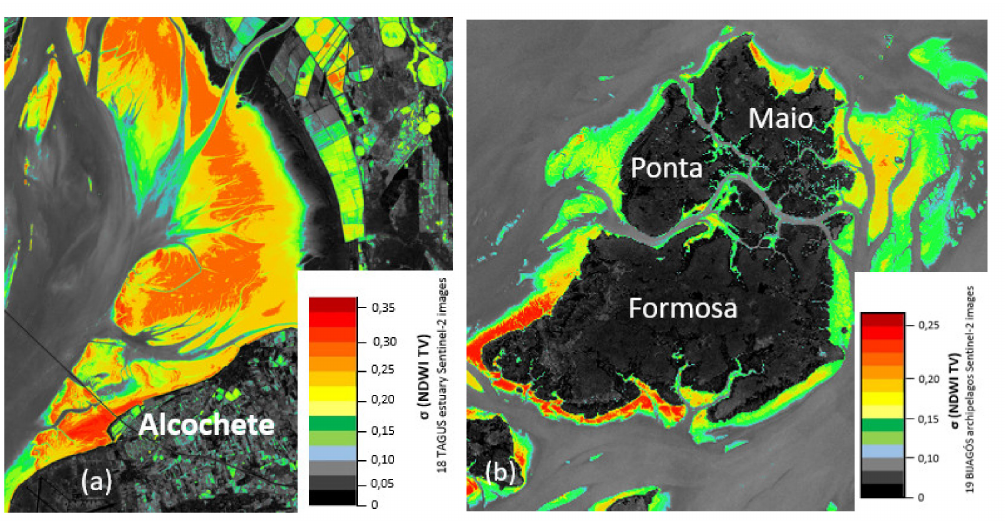
Figure 7. Normalized Di ff erence Water Index (NDWI) temporal variability: ( a ) Alcochete area in Tagus estuary and ( b ) Formosa, Maio, and Ponta islands at Bijag ó s archipelagos.